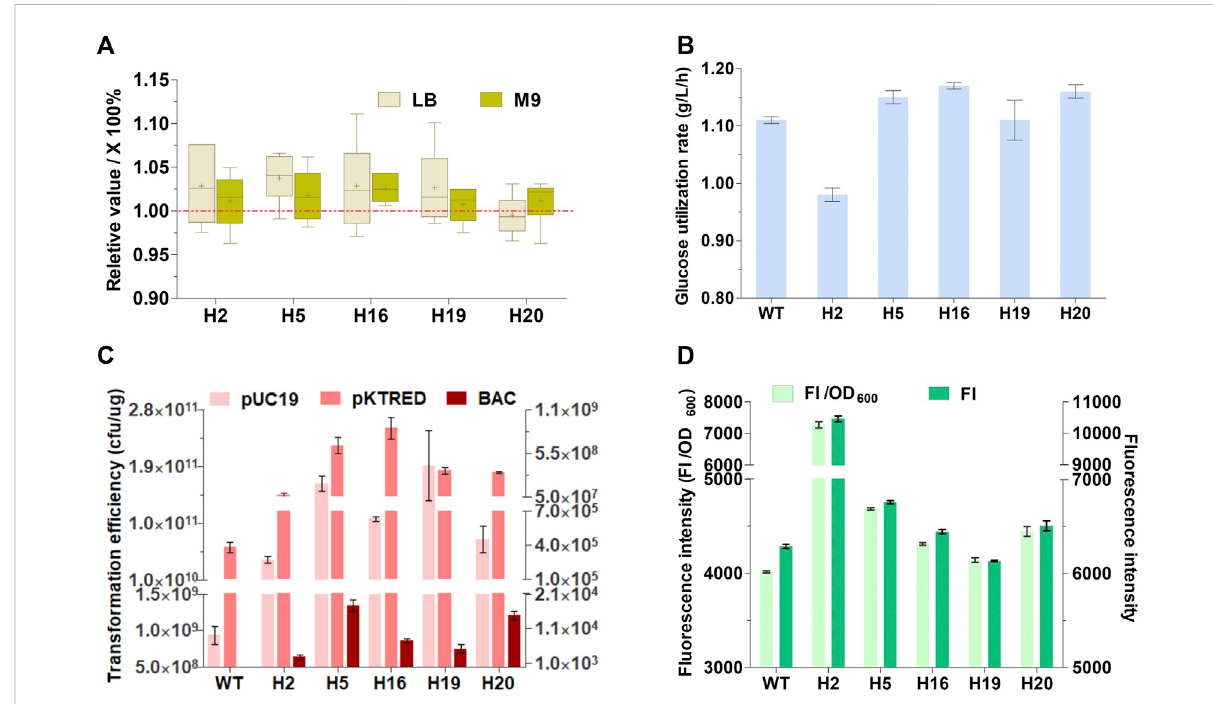
FIGURE 2 Physiological characteristics of the genome-reduced mutants. (A) The maximal growth rate (h − 1 ) in LB rich medium and M9 minimal medium. Data presented here are the relative growth rates compared with wild-type MG1655 (WT) that are calculated as thepercentage ofthe growth rate of mutants against the WT. The maximal growth rate of the fi ve genome-reduced mutants and WT were measured in LB rich medium and M9 minimal medium (The data were shown in Supplementary Table S4). For each strain, six replicates were carried out. Center lines show the medians. “ + ” indicate the means. Box limits indicate the fi rst and third quartiles. Whiskers show either the maximum (or minimum) value or 1.5 times the interquartilerange,whicheverissmaller(orlarger),andtheoutliersarerepresentedbydots. (B) Maximalglucoseutilizationrateinexponentialphase. (C) Electroporation ef fi ciency; The absolute electroporation ef fi ciency of the WT and the genome-deleted mutants were calculated with a small multicopy plasmids pUC19, a low-copy plasmids pKTRED, and a BAC with a 92-kb fragment insertion. The electroporation ef fi ciency refers to